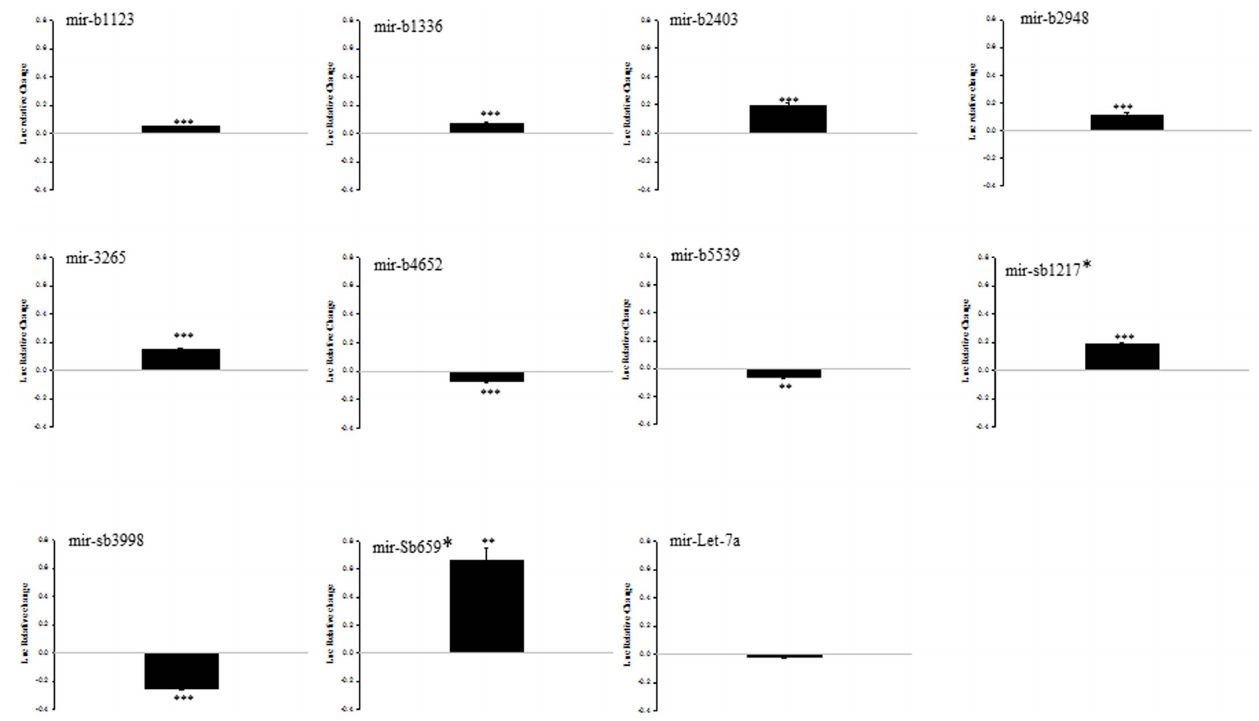
Figure 4. A group of novel miRNAs dysregulated in sALS regulates the activity of a reporter linked to NEFL 3 9 UTR. Luciferase reporter gene assay was performed by transfecting HEK293T cells with pre-miRNAs and a reporter construct expressing Firefly luciferase coupled to NEFL 3 9 UTR. Data are expressed as relative change compared to empty vector and show positive values as up-regulation and negative values as down- regulation. Experiments were performed in triplicate. Results are shown as mean 6 SEM ( t -test: p , 0.001=***; p ,